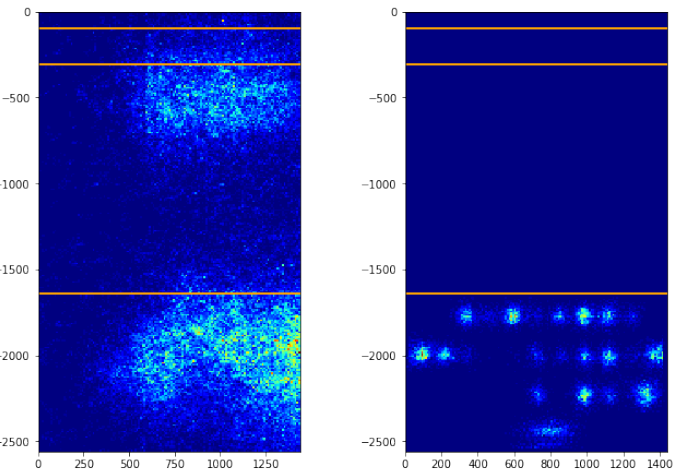
Figure 2. 2D-histogram of raw gaze data ( left ) and touch data ( right ), showing the misalignment between keyboard areas covered visually and by